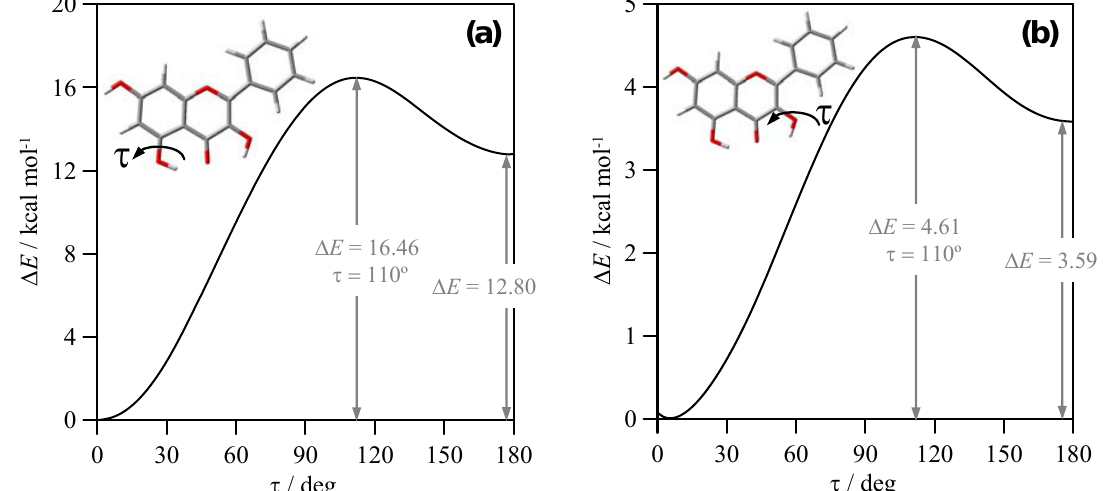
Figure 5. Relaxed potential energy scan for the reported dihedrals (involved in HB_1 and HB_2 as in Figure 4) in flavonoid IX (galangin), calculated in gas phase at B3LYP ⁄⁄ 6-311++G** theoretical level. Δ E is the energy relative to the conformer with lower energy (   (cid:31) 